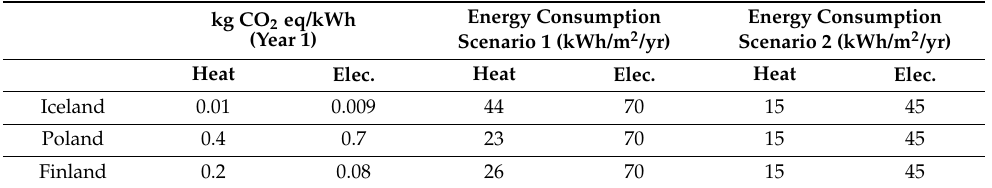
Table 4. The current energy GHG content and the assumed annual energy consumption in the two scenarios. Energy Consumption kg CO 2 eq/kWh (Year 1) Scenario 1 (kWh/m 2